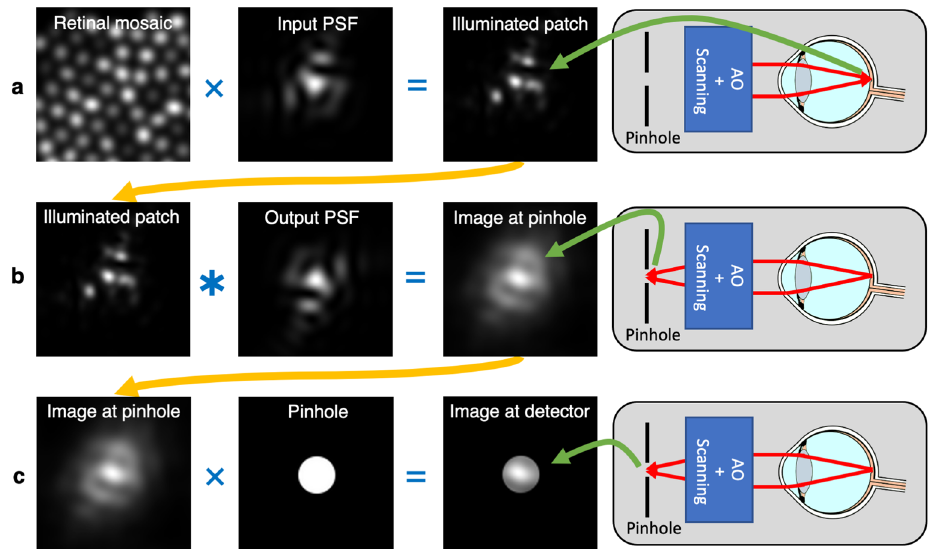
Figure 4. The steps to replicate data capture through a scanned confocal retinal imaging system, such as an AOSLO, which are shown schematically on the right. Step ( a ) shows the illumination of a patch of retina by a point source directed through the system and the eye’s optics (Input PSF), which may be degraded by the eyes optics. This step is represented by the multiplication of the reflectance profile of the retinal patch and the input PSF. Step ( b ) shows the process of re-imaging the illuminated patch of the retina through the system and the eye’s optics (Output PSF) to the plane where the pinhole is located. This step is computed as a convolution of the illuminated patch of retina with the output PSF, noting that the wavefront is inverted in the outward direction (this operation is equivalent to the cross-correlation of the illuminated patch with the input PSF). Step ( c ) shows the transmission of the final image through the pinhole to give the image that would be seen by the detector. This step is computed as the multiplication of the image at the pinhole by the transmission function of the pinhole, which we consider to be 1 inside and 0 outside a uniform disc. The final step is summation of the image formed behind the pinhole, to replicate integration by the detector (neglecting noise), giving the signal at the current position in the scan, I(x,y) . Steps ( a–c ) are repeated for every sample location as the beam is raster scanned over a region of the retina. Note that while this model allows for a different input and output PSF, in practice we assume that the input and output PSFs are the same (the PSF of the eye, which includes diffraction